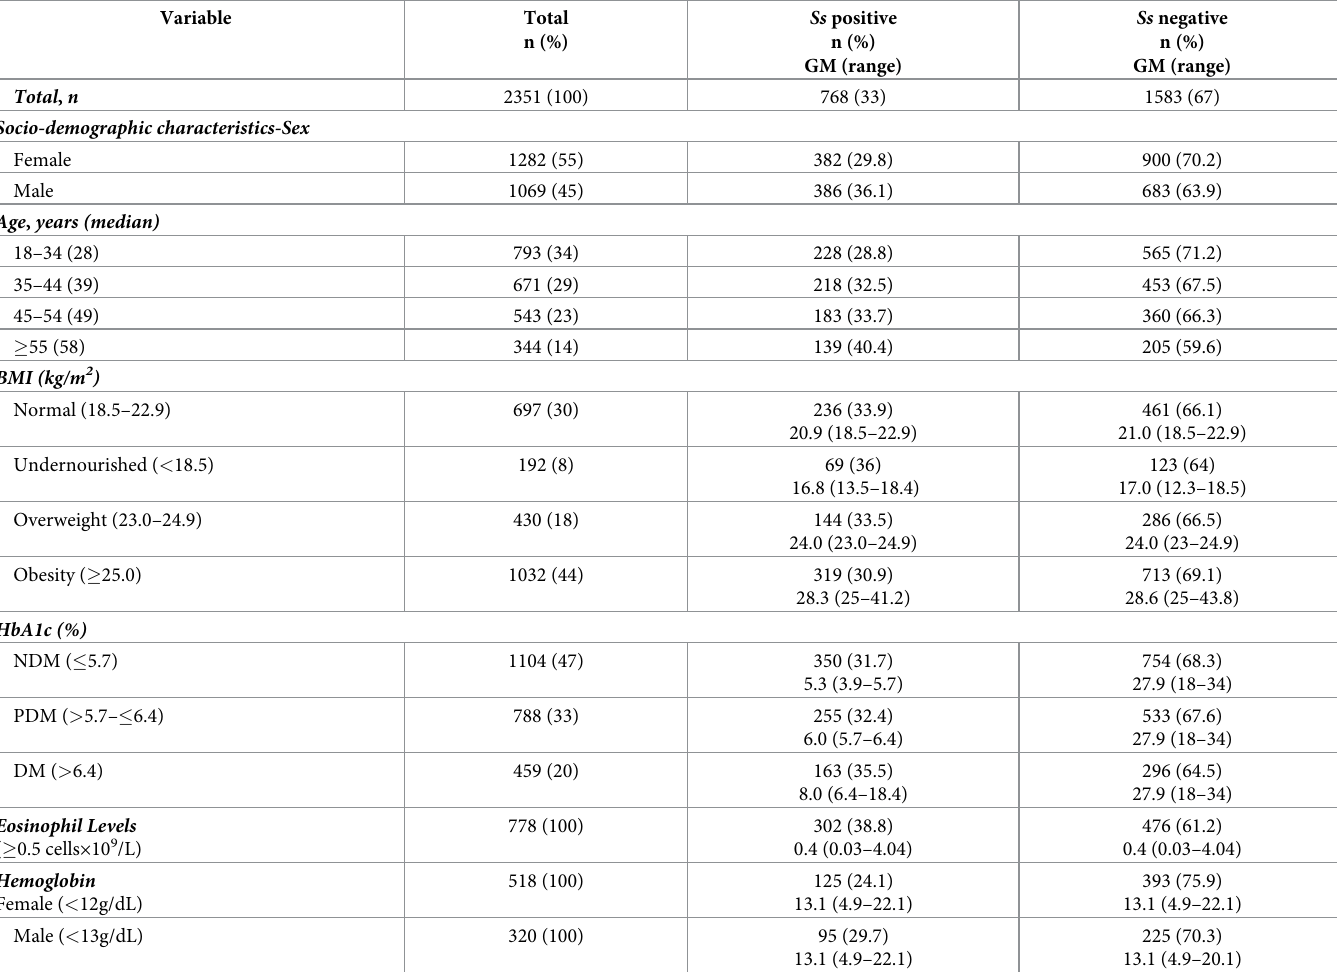
Table 1. Socio-demographic and clinical characteristics of Stongyloides stercoralis infected South Indian adult population enrolled between 2013 and